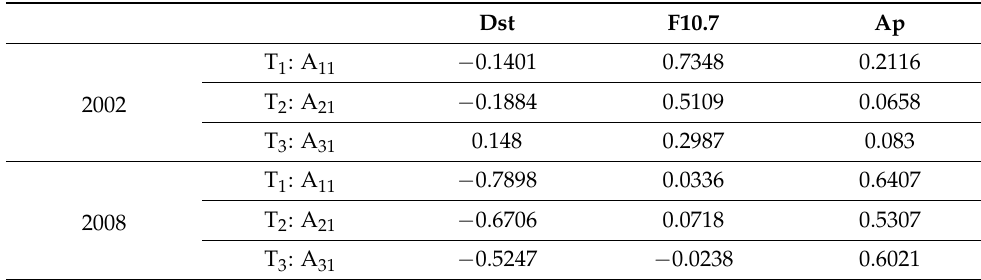
Figure 1. Solar radiation and geomagnetic conditions in 2002 (red lines) and 2008 (blue lines): ( a ) F10.7 index, ( b ) Ap index, and ( c ) Dst index. Table 3. The correlation coefficients obtained from the correlation analysis of the A i1 annual variation curve with Dst, F10.7, and Ap in 2002 and